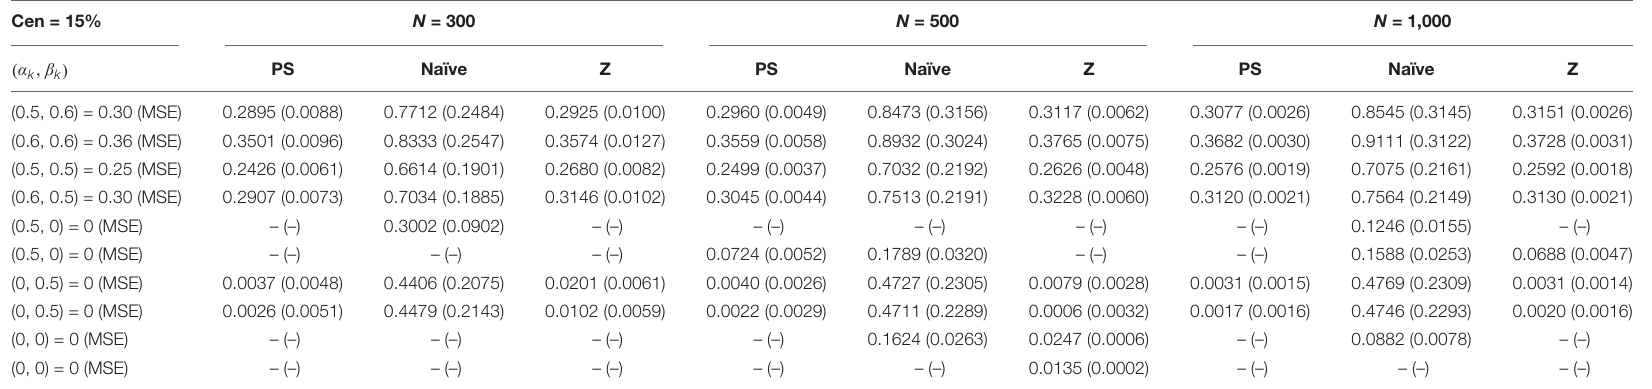
TABLE 2 | Estimation of log hazard mediation effects: α k β k (Cen = 15%). Cen = 15%